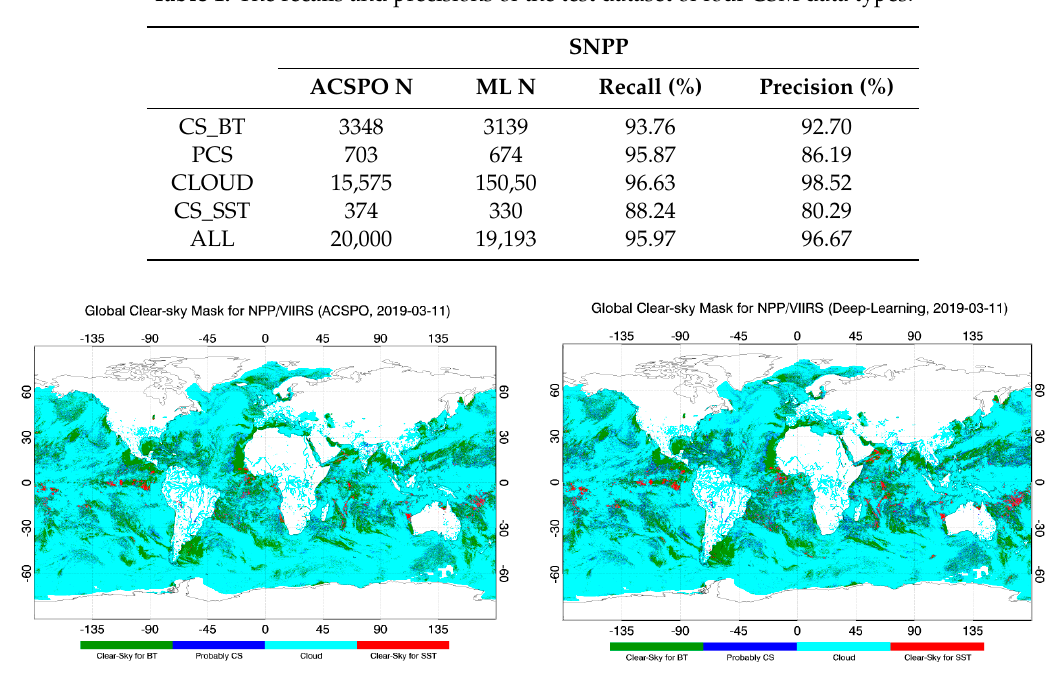
Figure 3. Global distribution of the four CSM types from Advance Clear-Sky Processor over Ocean (ACSPO) ( left ) and FCDN-CSM ( right ) for S-NPP.